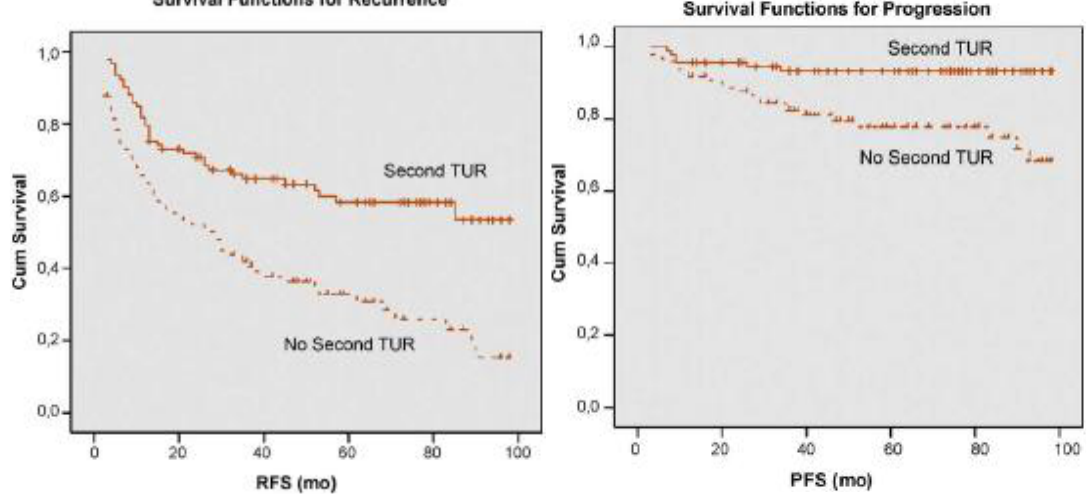
FIGURE 3. Recurrence-free and progression-free survival in pT1 bladder cancer patients after one vs. second